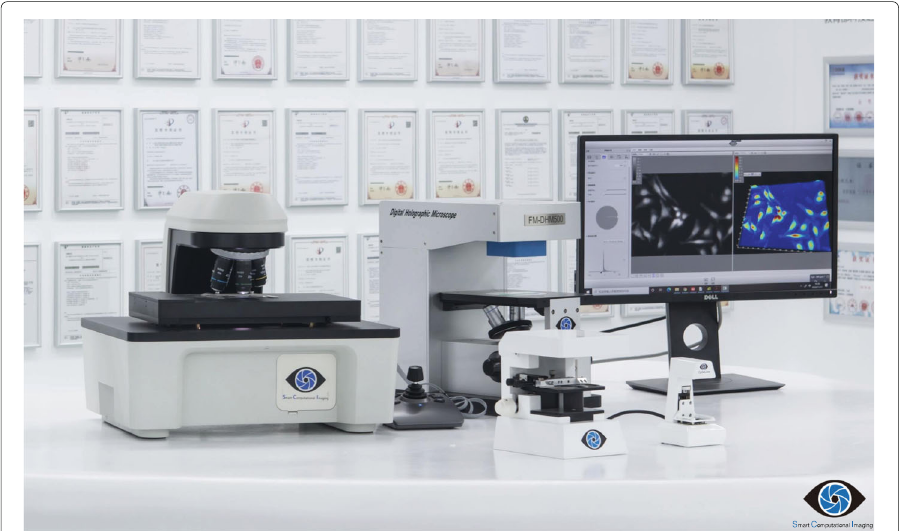
Fig. 3 Four SCLMs developed by our SCILab based on the principle of “computational imaging”. From left to right are MQP-SCLM, DH-SCLM, MMC-SCLM, and